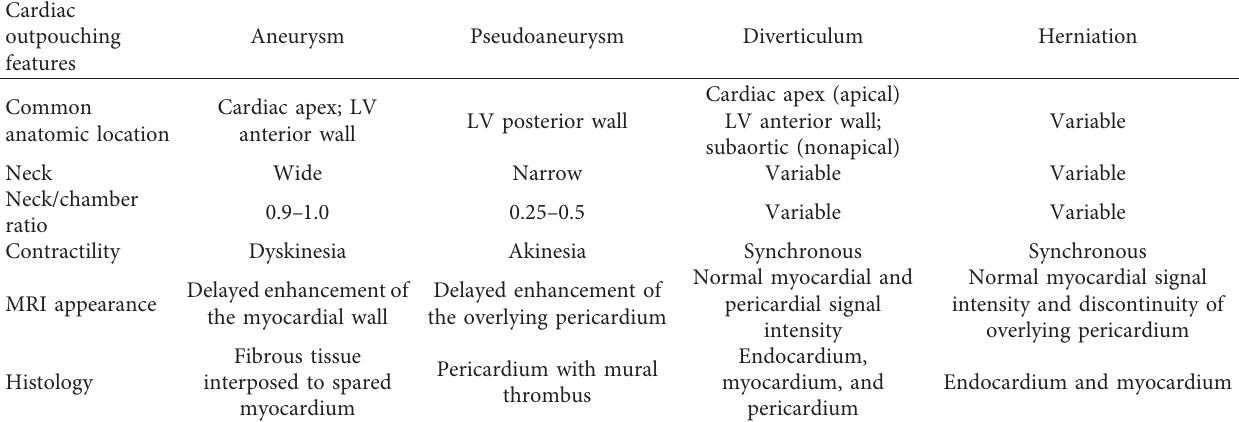
Table 1: Characterizing features of cardiac